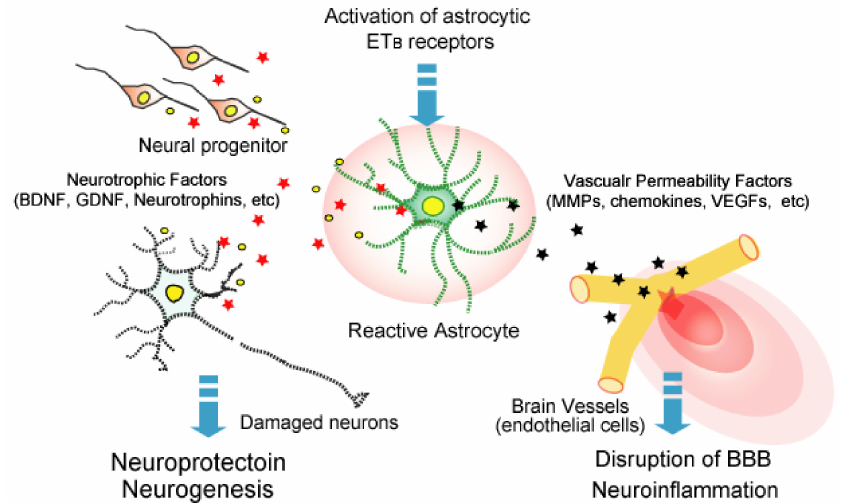
Figure 3. Roles of ET B receptor-mediated bioactive factor production from reactive astrocytes. In- creased ET-1 in brain disorders activates astrocytic ET B receptors and induces reactive astrocytes. Reactive astrocytes release various types of bioactive factors. These include factors that increase the permeability of brain microvessels to promote blood–brain barrier (BBB) disruption and neuroinflam- mation, and factors that promote nerve protection and